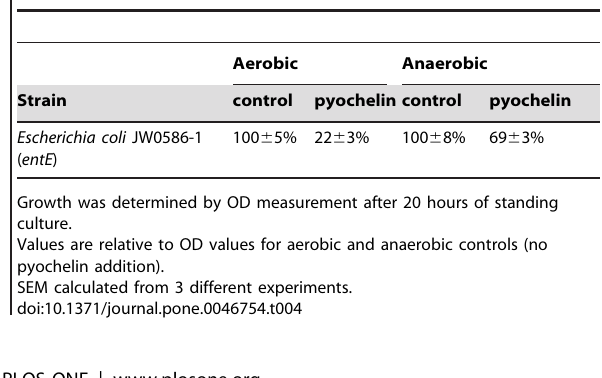
Table 4. Growth inhibition by pyochelin under aerobic and anaerobic culture conditions.